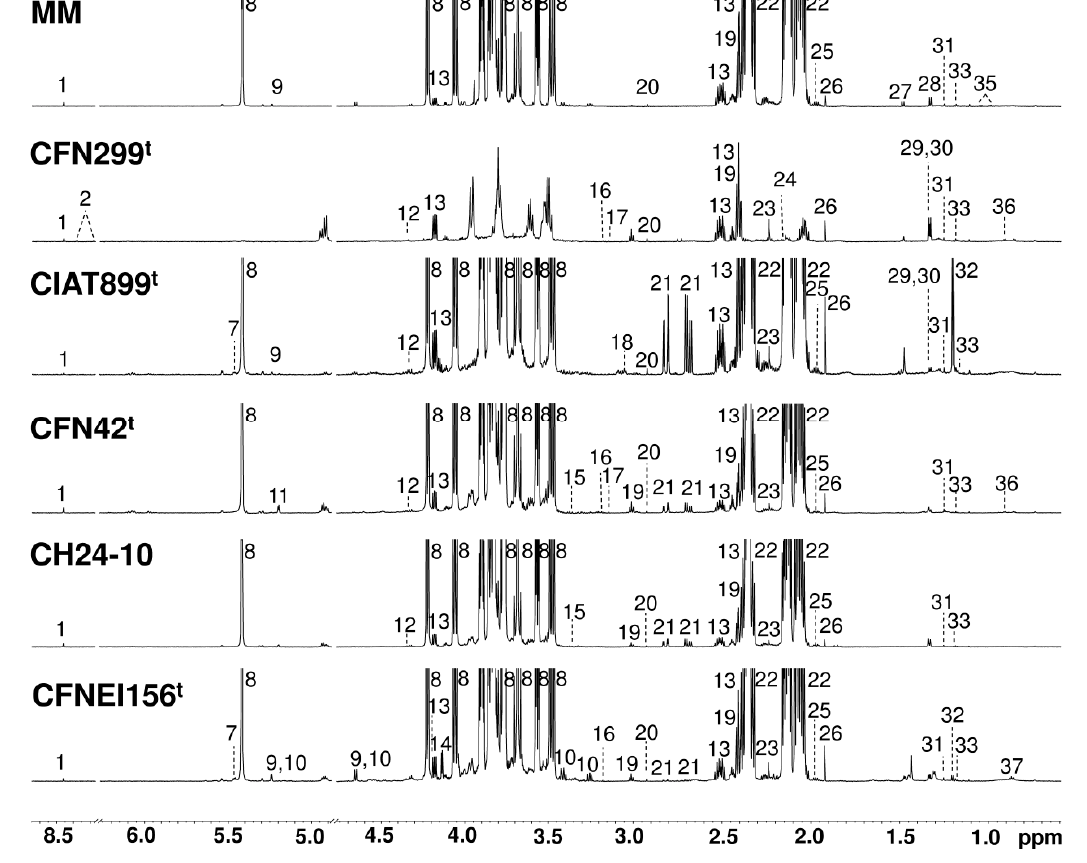
Figure 1. Representative 1 H nuclear magnetic resonance (NMR) spectra (700 MHz, 298 K, TSP = 1 mM, D 2 O sodium phosphate bu ff er 0.123 M at pH 7.4) of minimal medium (MM) and rhizobial strain culture supernatants at exponential growth (24 h). Labeled metabolites: 1: